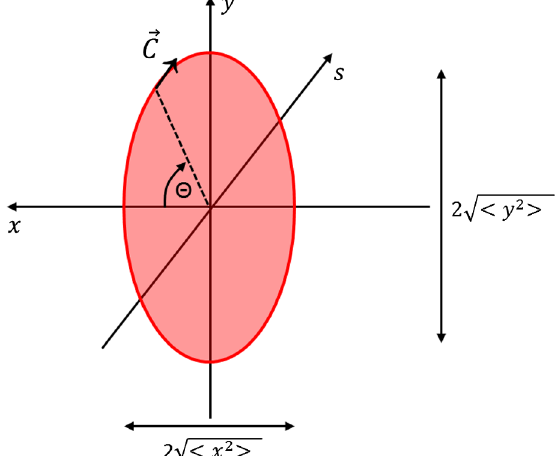
FIG. 4. Visualization of the rms-vorticity W A for a beam with h xy i ¼ 0 . The integration path encloses the elliptical beam rms-area.